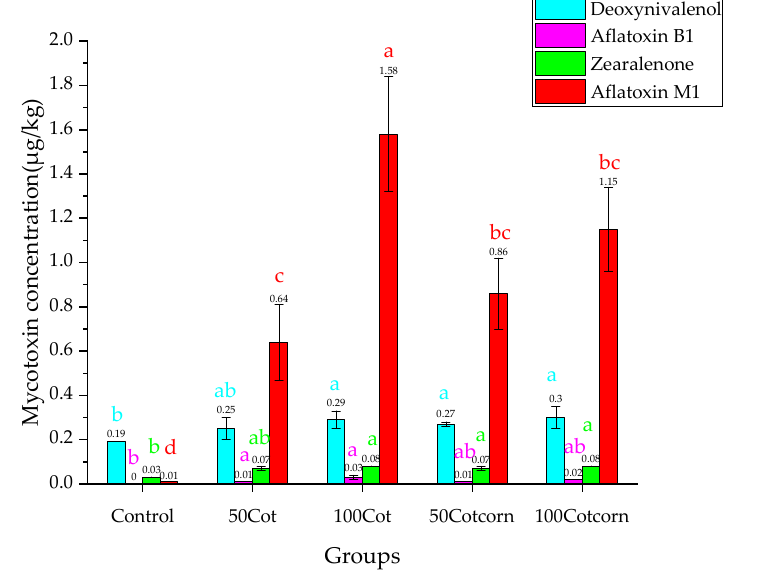
Figure 1. Concentrations of major mycotoxins in milk of dairy cows fed diets containing mildewy corn meal and cottonseed. Different letters (a, b, c, and d) denote significant differences ( p < 0.05).